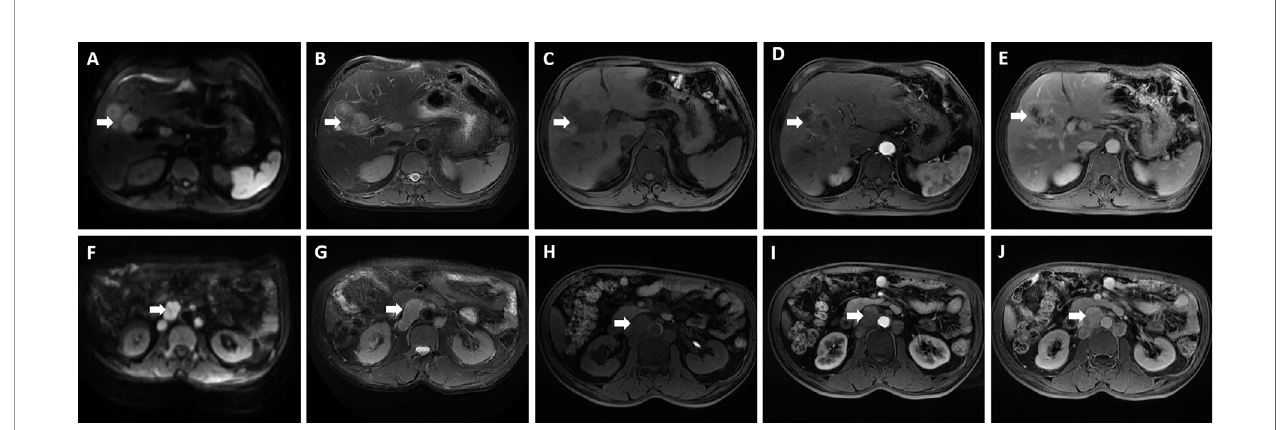
FIGURE 3 | Magnetic resonance imaging showed an irregular morphology mass, with low signal in T1-weighted imaging, high signal in T2-weighted imaging, and limited diffusion in diffusion-weighted imaging (DWI); enlarged hepatic portal and retroperitoneal lymph nodes were also revealed — the larger one was 30.4 mm * 23.1 mm in size. (A, F) DWI; (B, G) T2-weighted imaging; (C, H) T1-weighted imaging; (D, I) The arterial phase; (E, J) The delayed phase. The white arrowheads direct the lesion or enlarged lymph nodes.